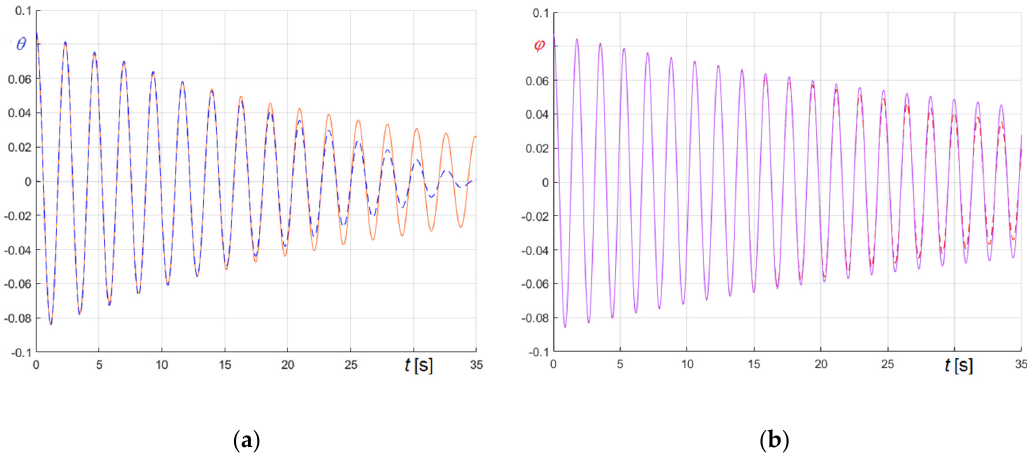
Figure17. Comparisonoffrictiondamped(dashedlines)andequivalentviscousdamped(solidlines)for Figure 17. Comparison of friction damped (dashed lines) and equivalent viscous damped (solid lines) for smallamplitude(5 ◦ )freeoscillationsofSt. Mary’stenorbell: ( a )Belloscillations; ( b )Clapperoscillations. 20b to the case I.a. small amplitude (5°) free oscillations of St. Mary’s tenor bell: ( a ) Bell oscillations; ( b ) Clapper oscillations.